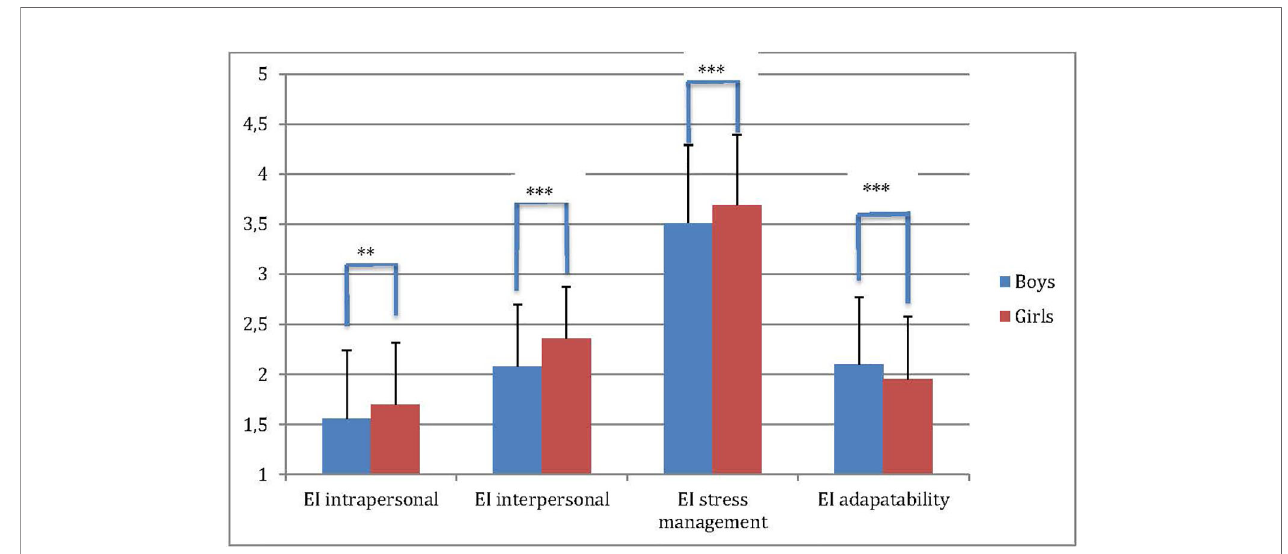
FIGURE 1 | Emotional intelligence scores contrasting boys and girls (** p < 0.01; *** p <